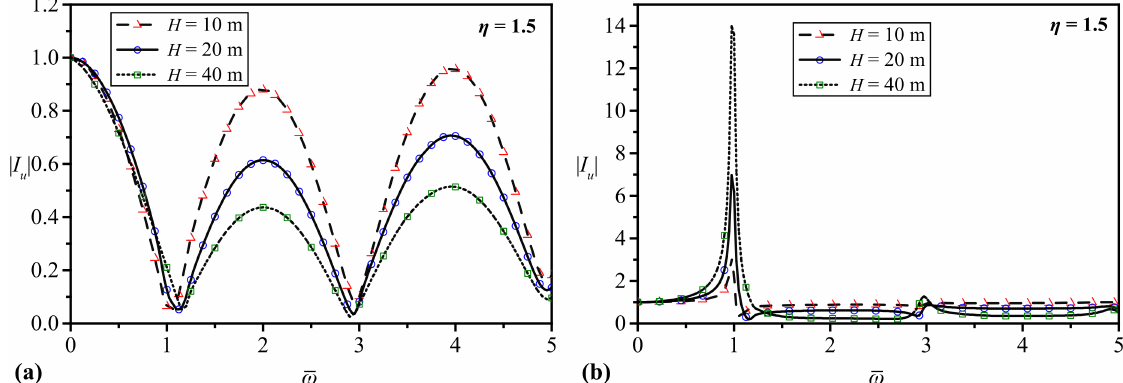
Figure 7. The effects of the pile length ( H ) on the kinematic response and amplification factors of piles ( ρ p = 2500 kg/m 3 , E p = 36 GPa, r 0 = 0.5, υ j = 0.4, β j = 0.2, G N +1 = 36 MPa, H = 20 m, η = 1.5).